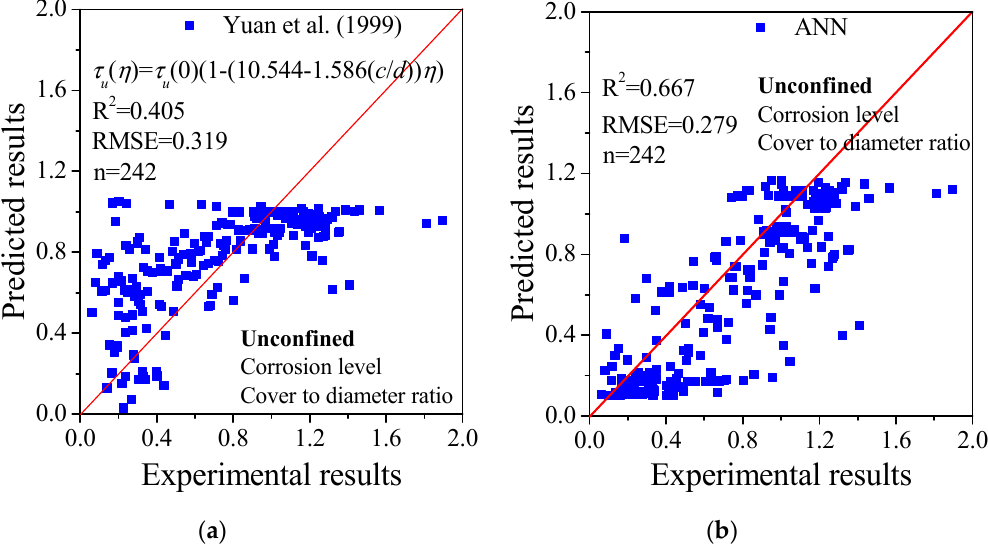
Figure 7. Comparison between the existing analytical models and ANN method considering both corrosion level and cover-to-diameter ratio as inputs for specimens without stirrups (unconfined) (note τ u ( η ) is the bond strength of specimen with corrosion level of η , τ u (0) is the bond strength of specimen without corrosion damage and η is the corrosion level and c / d is the cover-to-diameter ratio): ( a ) Yuan et al. (1999) [54]; ( b ) ANN.